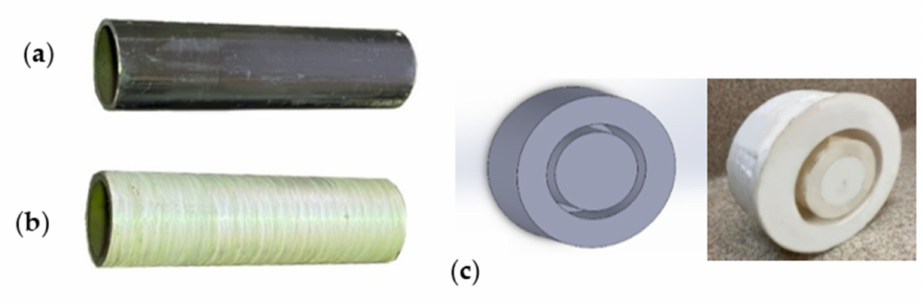
Figure 1. The prepared specimens, ( a ) steel pipe, ( b ) GFRP overwrapped steel pipe, and ( c ) Teflon cups, to close the two ends of the pipes.